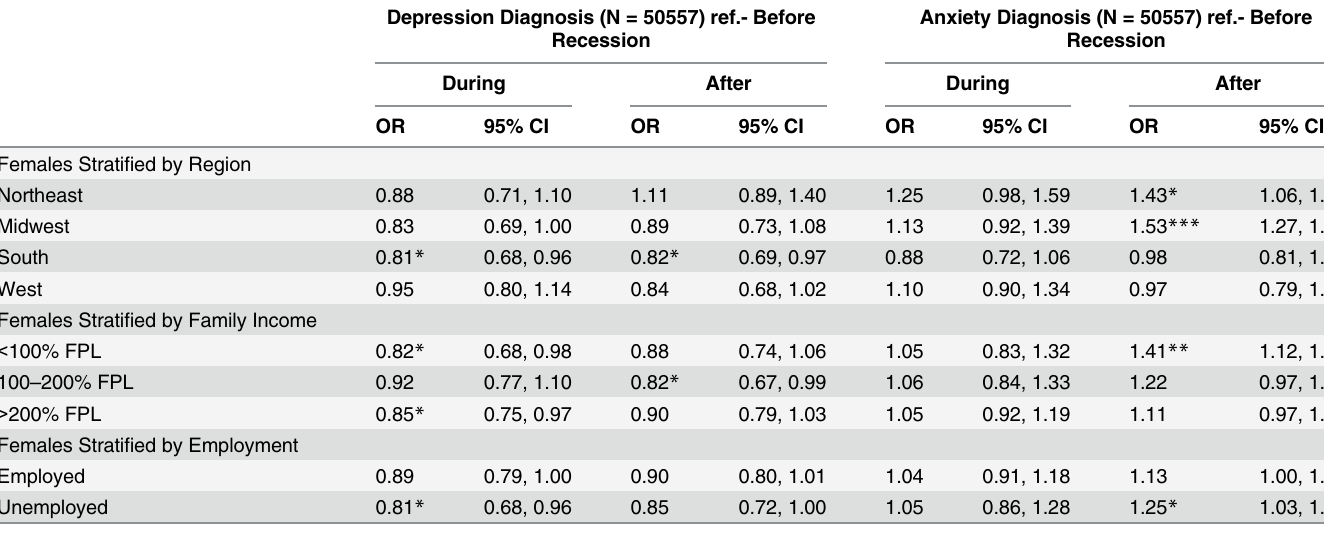
Table 3. Stratified multivariate analyses of recession indicators (during and after) and mental health diagnoses for females. Depression Diagnosis (N = 50557) ref.- Before Anxiety Diagnosis (N = 50557) ref.- Before Recession Recession During After During After